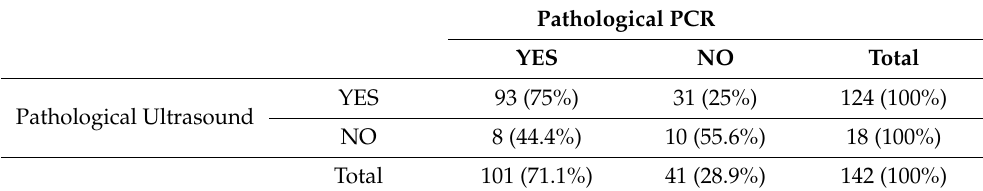
Table 3. Pathological ultrasound-PCR relationship.